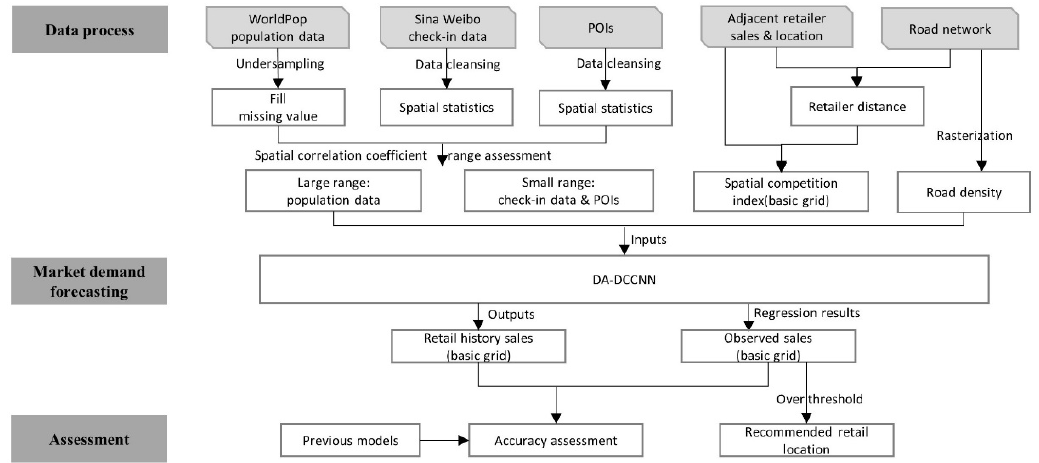
Figure 3. Framework for using the data augmentation-double-channel convolutional neural network (DA-DCCNN) to address retail competitive site selection.